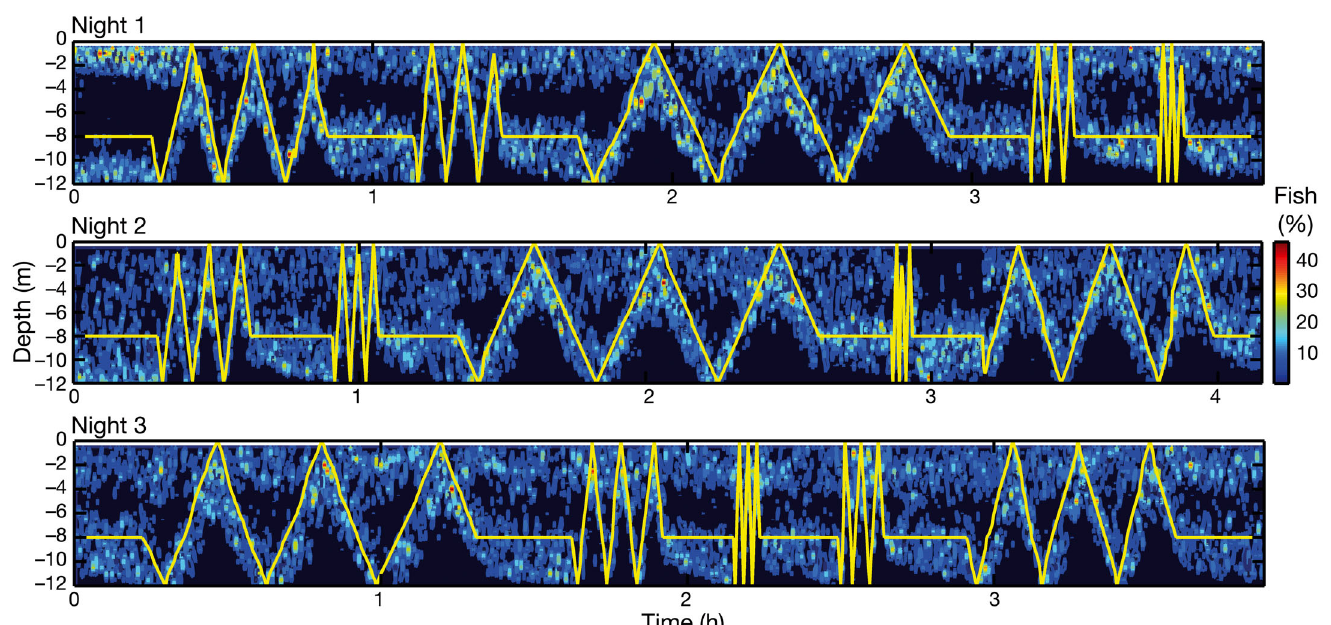
Fig. 1. Depth distribution (colour-coded percentages of fish at 0.5 m depth increments using data from a single cage) of At- lantic salmon Salmo salar during the 3-night study where fixed submerged lights positioned at 8 m were moved at a constant rate between 0−12 m for 3 cycles at 5 different speeds (yellow line indicates light